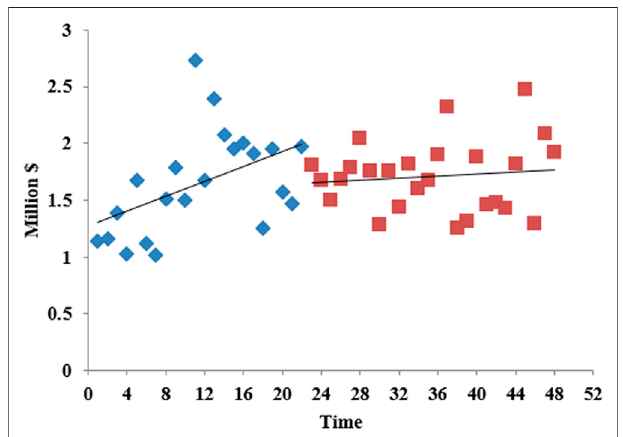
FIGURE 6 | The total expenditure on carbapenem in Shaanxi Province, 2017 – 2020.